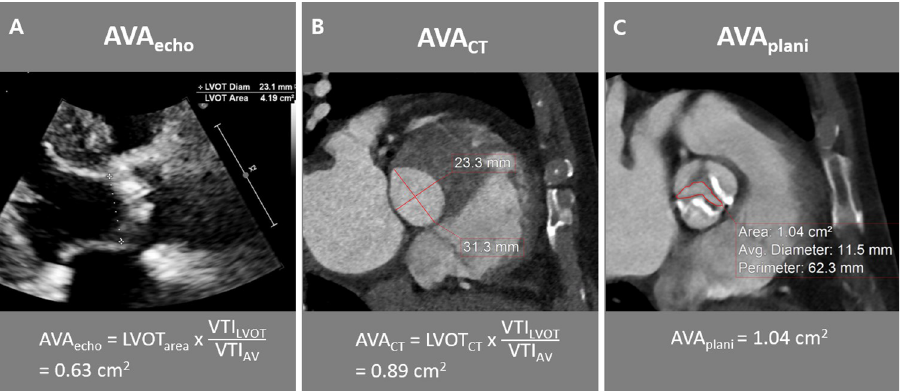
Fig 1. An example of aortic valve area (AVA) measurement using echocardiography or CT in a 74-year-old male who diagnosed as severe stenosis of fused bicuspid aortic valve. AVA, aortic valve area; LVOT, left ventricular outflow tract; VTI, velocity time